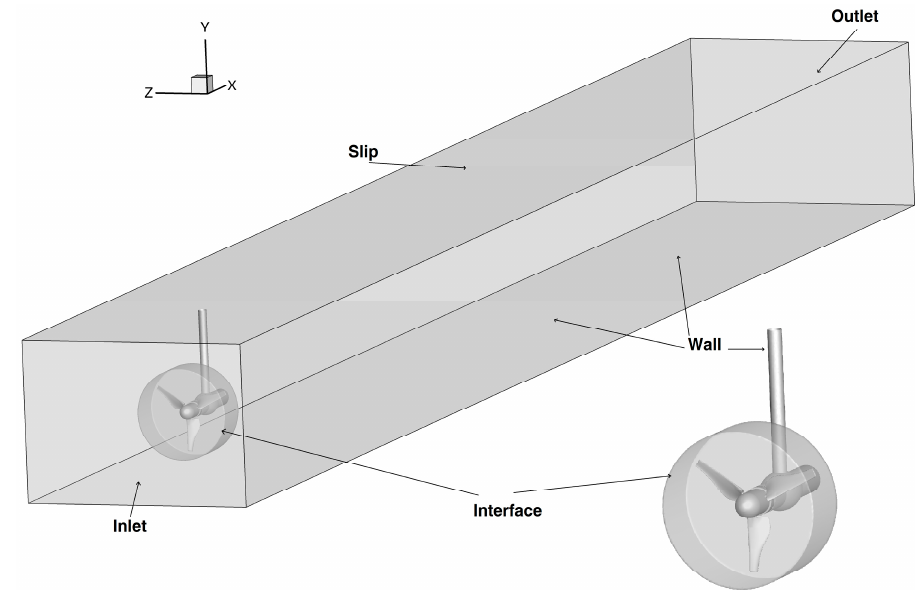
Figure 2. Simulation domain and boundary conditions. Inset figure shows the rotating cylindrical domain for turbine blades and hub.